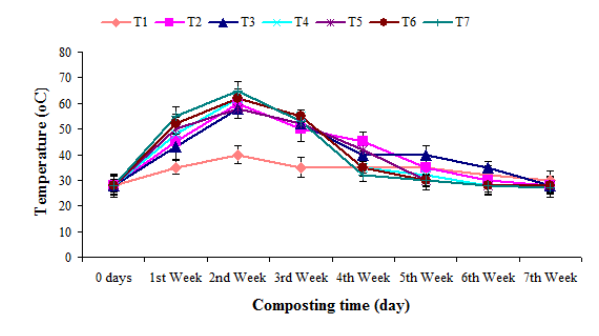
Fig. 3. Changes of Temperature during composting of press mud with cattle manure. T PM + Enterobacter sp. + CM; T T : PM + Proteus sp. + CM; T 4 PM + Cellulomonas sp.+ CM; T : PM + 2 : PM 4 : PM + 6